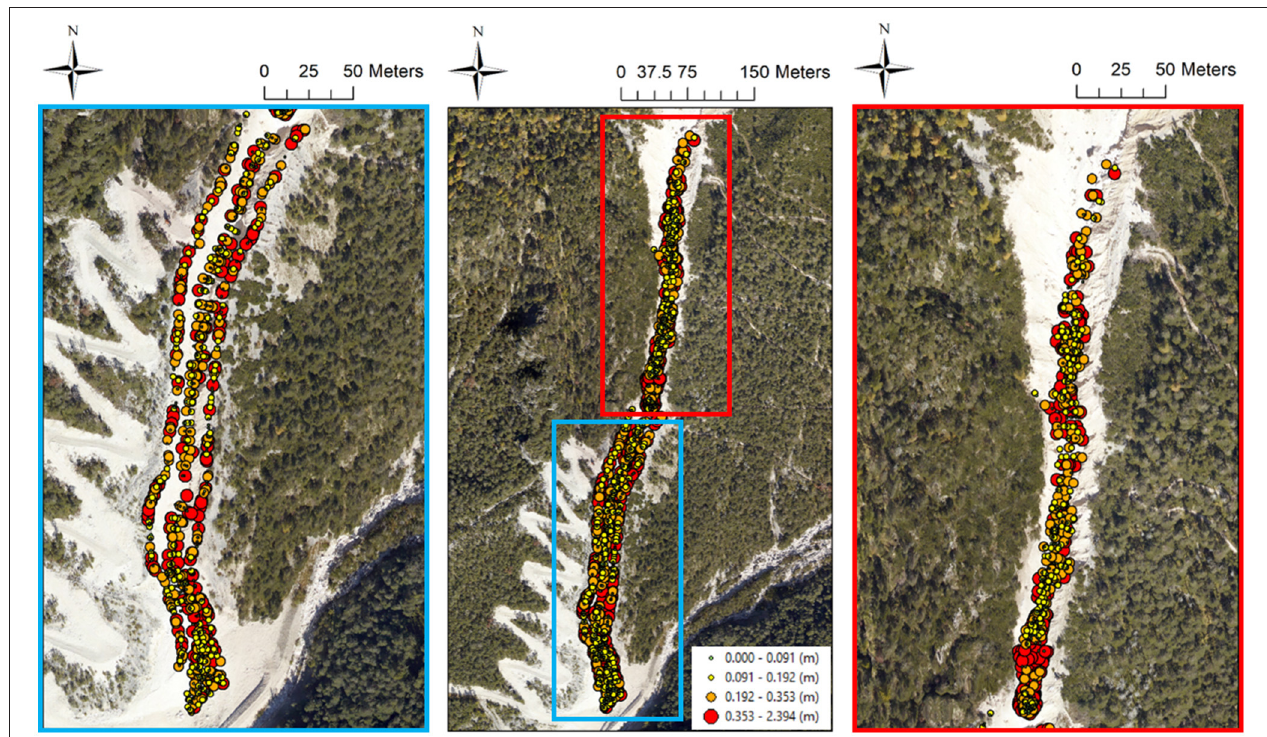
FIGURE 5 | Choropleth symbol map of the thin-plate spline function absolute errors (spatial resolution of 1.00m). Note that the greatest absolute errors mainly occur at the top of the banks and in the rough upper part of the study area. Within the channel the spatial pattern of errors appears to be